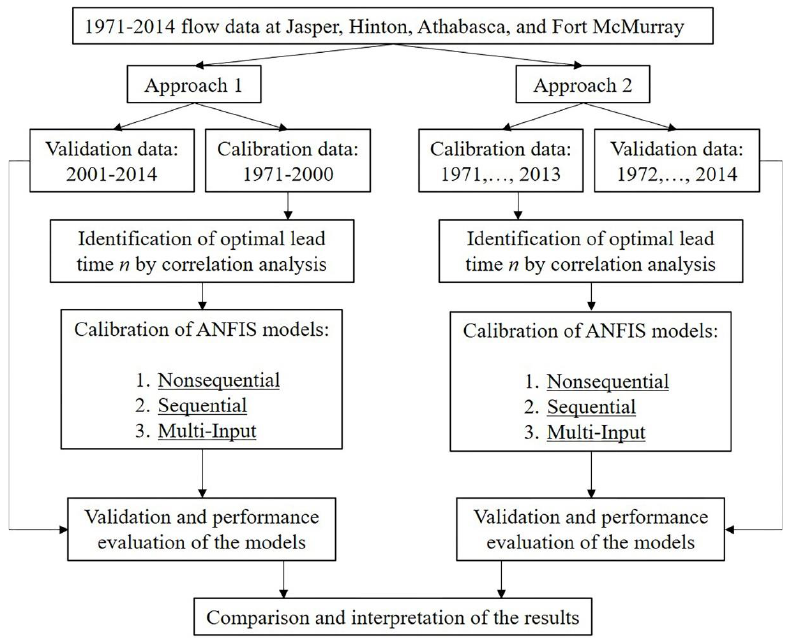
Figure 2. Conceptual diagram of the approaches and methods adopted in this study.